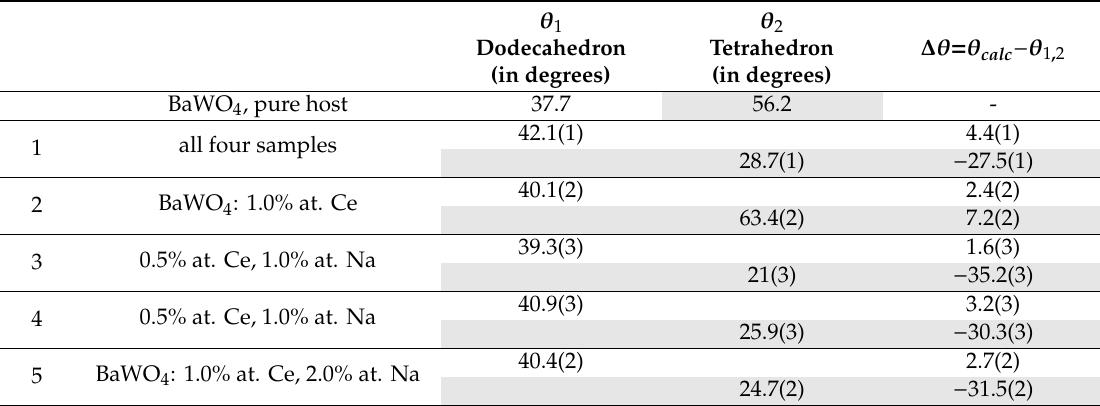
Table 4. The values of polar angles ( θ ) for Ce 3 + centers in BaWO 4 single crystals for dodecahedra [CeO 8 ] and the tetrahedron [CeO 4 ] (grey